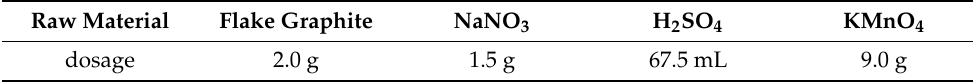
Figure 1. Schematic diagram for the synthesis process of TiO 2 -RGO nanocomposites. Table 1. Mixture proportion for the modified Hummers